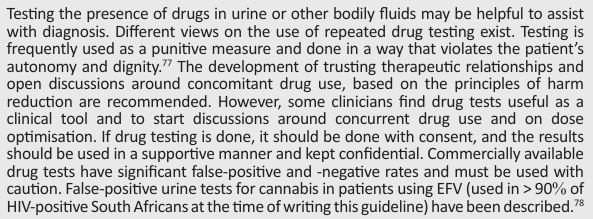
BOX 18: Opioid substitution therapy and overdose risk. 84